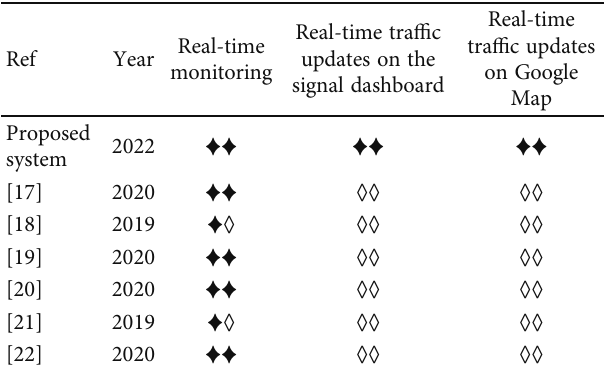
Table 3: Comparison of the proposed approach with existing